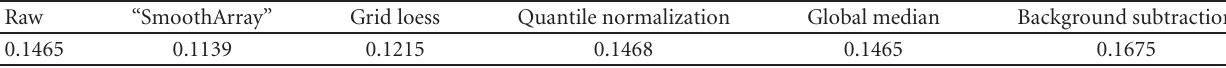
Table 2: Table comparing the median MAD values on the X chromosome for each of the normalization methods. From this metric, we see that the “SmoothArray” normalization procedure provides the optimal noise reduction for probes on the X chromosome.